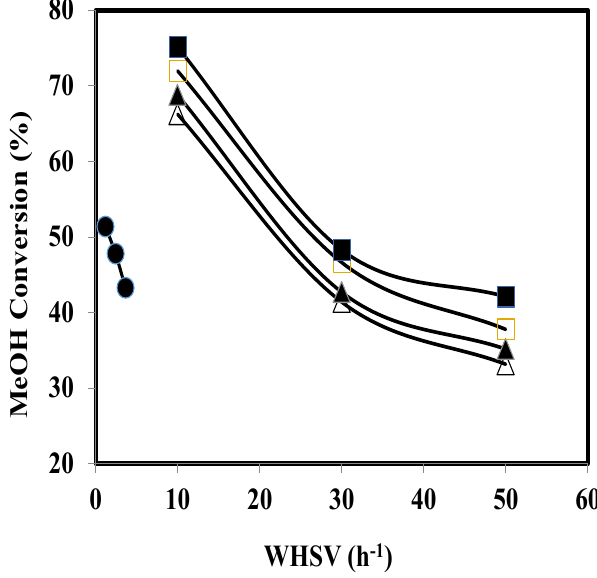
Fig. 8. Methanol conversion versus WHSV for fixed bed reactor in comparison with micro-channel reactor at 290 o C. Micro-chan- nel reactor (●). Fixed bed reactor: P.S.<0.063mm ,0.063< P.S. <0.125mm (□),0.125< P.S. <0.5mm (▲),0.5< P.S. <1mm (∆).